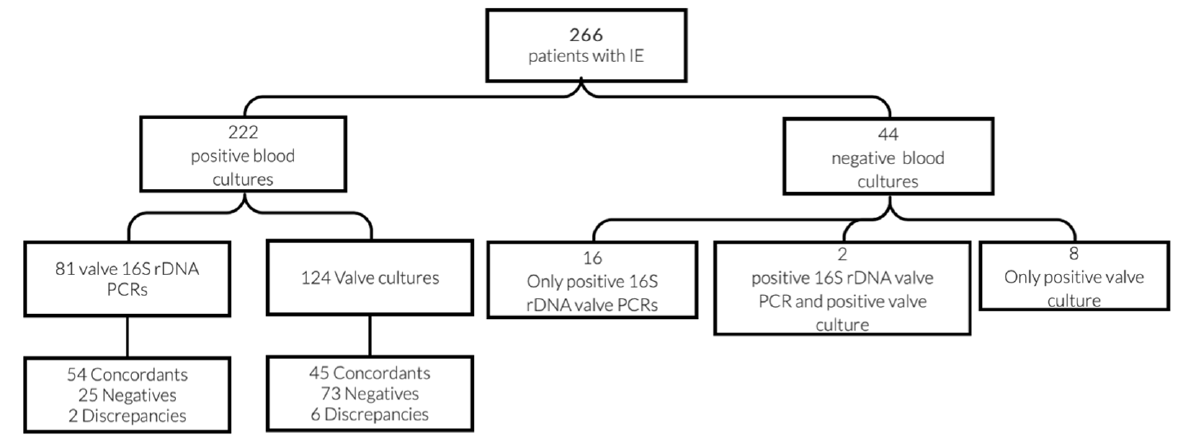
Figure 3. Concordance between blood and heart valve culture and/or 16S rDNA valve PCR results.